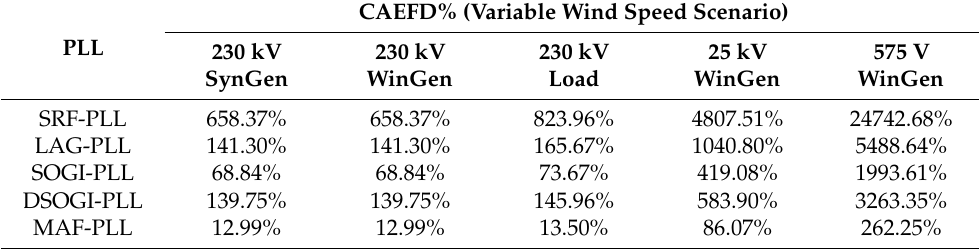
Table 8. Cumulative relative AEFD values for the PLLs located at different buses in the variable wind speed scenario.